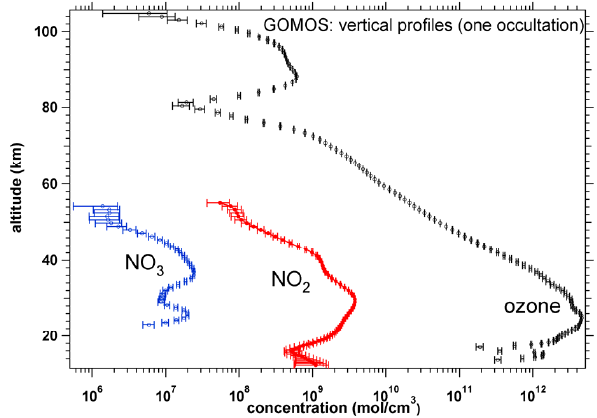
Fig.14. Vertical profiles and their error bars for ozone, NO 2 and NO 3 retrieved from one single occultation of the star Sirius.